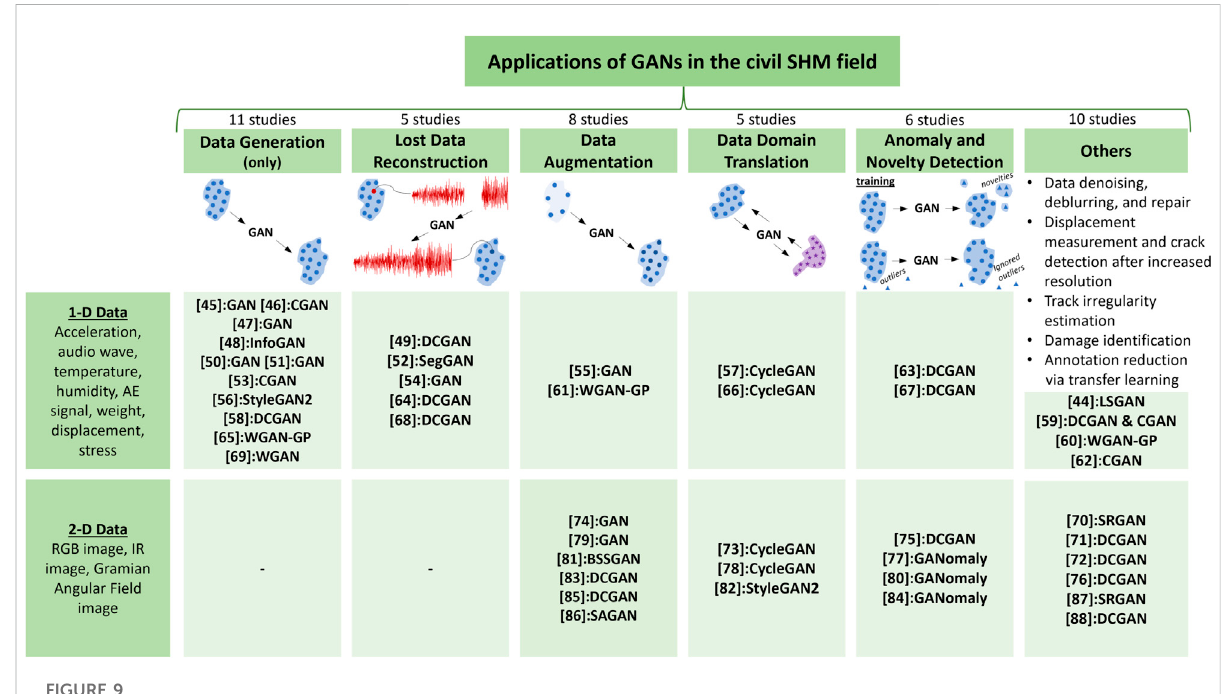
FIGURE 9 Classi fi cation of the applications of GANs in the civil SHM fi